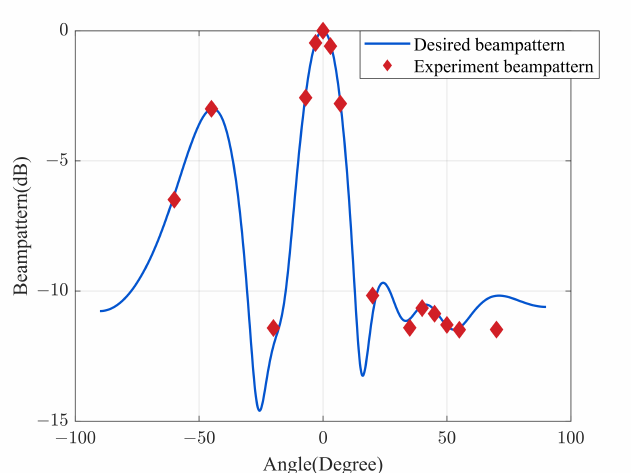
Figure 12. Comparison of the desired synthetic waveform (blue) and the experimental synthetic waveform (red) in communication direction. ( a ) Comparison in the time domain. ( b ) Comparison for the phase.